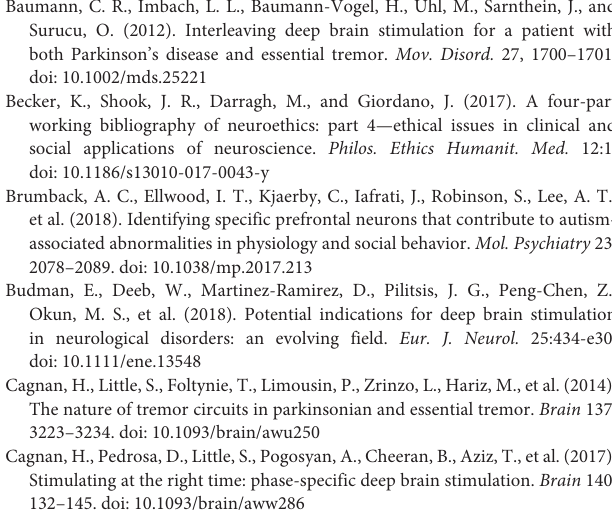
FIGURE S2 | Example of a neuronal closed loop-DBS trial: upper panel demonstrates fluctuation of subthalamic nucleus (STN) beta power within, above and below the dual thresholds; lower panel demonstrates the DBS voltage response. The insert highlights the decision events over a 1 s period, whether DBS voltage increased (red triangles), stayed the same (no symbols), or decreased (blue triangles). From Velisar et al. (2019) with permission. FIGURE S3 | Real-time collection of local field potential to enable high accuracy differentiation of clinical states for adaptive neuromodulation (i.e., home environments). FIGURE S4 | DBS evoked resonant neural activity (ERNA). (A) Applying stimulation in the vicinity of the STN elicits evoked responses with decaying oscillation morphology. Columns show the ERNA recorded at each electrode when stimulation was applied to different electrodes (indicated by crossed axes) in a person with PD. A 3D reconstruction illustrating electrode positions (green: STN, blue: substantia nigra). (B) Normalized ERNA amplitude varies with electrode position with respect to (w.r.t) the STN in people with PD (20 hemispheres tested; box: 25th–75th percentiles; line: median; whiskers: range). *** p ≤ 0.001, ** p < 0.01, * p < 0.05. (C) Mean Unified Parkinson’s Disease Rating Scale (UPDRS) improvement from stimulation after ranking electrodes within each hemisphere according to ERNA amplitude (rank 1: largest ERNA; bars: standard error). Results from 10 PD patients tested post-surgery (20 hemispheres). (D) ERNA recorded in a person with PD at electrode implantation (blue) and under general anesthesia 560 days postop (red). (E) ERNA frequency decreases with increasing DBS amplitude (19 hemispheres tested). Red bars: p ≤ 0.001; yellow bars: p < 0.05. (F) ERNA frequency correlates with relative beta band (13–30 Hz) amplitude across the stimulation levels shown in ( E ; ρ = 0.58, p < 0.001). Colors represent different hemispheres tested. Panels (A–D) from Sinclair et al. (2018) with permission. Panels (E,F) from Sinclair et al. (2019) with permission. FIGURE S5 | Illustration of Pathway Generation Process including: (A) histological data from the Morel atlas, (B) histological data fitted to the CIT 168 brain atlas, (C) preliminary pathway trajectories were generated using information from the MRI, histology, and previous literature, (D) mean trajectories were generated for each pathway, (E) preliminary streamline bundles were generated, (F) using the HoloLens system, these pathways were visualized, discussed, and manually edited via holographic interactions with the neuroanatomists and (G) finalized pathways. From Petersen et al. (2019) with permission. FIGURE S6 | Hype Cycle schematic representation. This Figure represents the position of certain DBS-associated technologies at different stages of development on the Hype Cycle curve (Fenn,